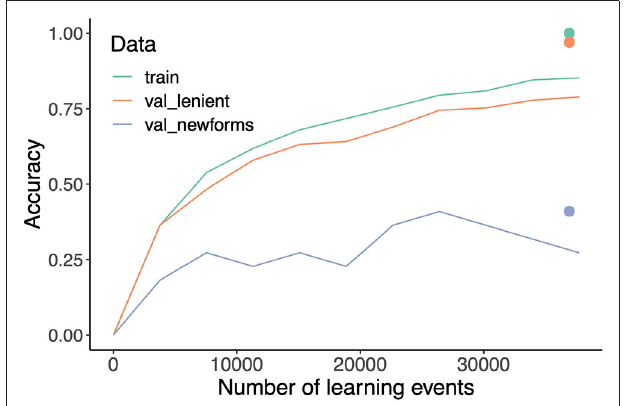
FIGURE 4 | Comprehension accuracy over the course of learning. After a very fast increase in accuracy over the first 15,000 learning events, the amount of learning levels off. Points indicate the accuracy at the end-state of learning which the incremental model would reach eventually after an infinite number of learning events.